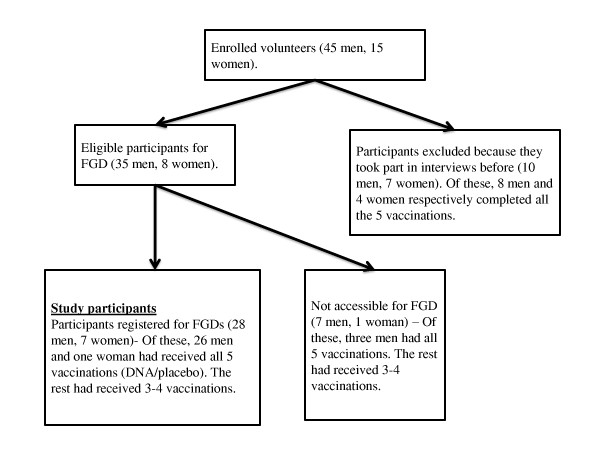
Sampling framework.